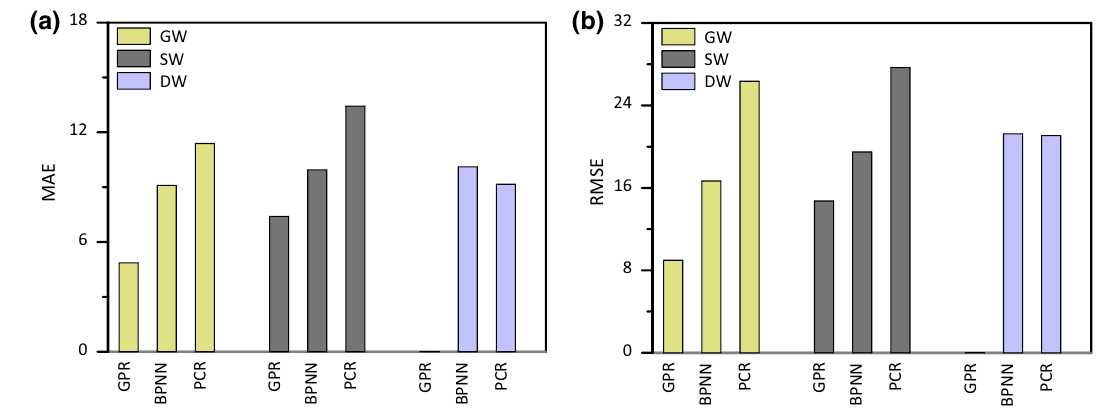
Fig. 10 Performance of TDS prediction in GW, SW and DW using three different models: a MAE; and b